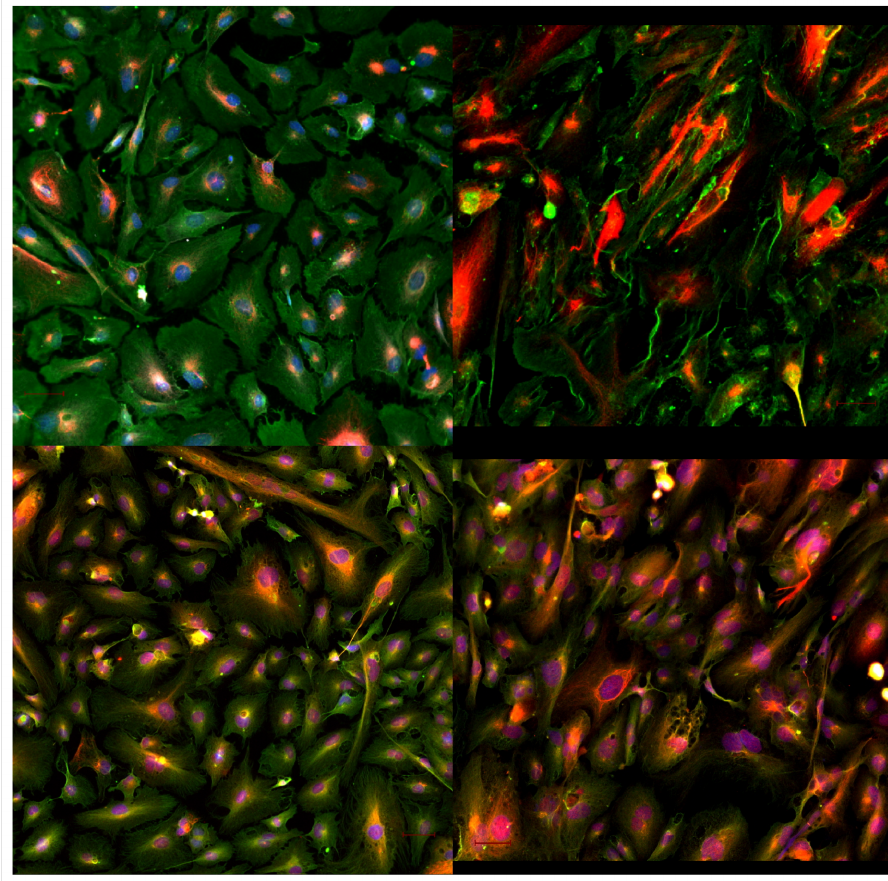
Figure 2. ( Upper panel ): acetylated (red) and polyglutamylated (green) tubulin of control (left) and stretched (right) cardiac fibroblast cells. ( Lower panel ): detyrosinated (red) and tyrosinated (green) tubulin of control ( left ) and stretched ( right ) cardiac fibroblast cells. The rearrangement of the tubulin mesh caused by a mechanical strain not only influences the shape and morphology of the cells but requires an incredible number of finely tuned modifications of the single units that compose the microtubuli in a matter of minutes, all shared and synched by each of the cells that compose the tissue. The microphotographs show a 20 × fluorescence acquisition of cardiac fibroblast